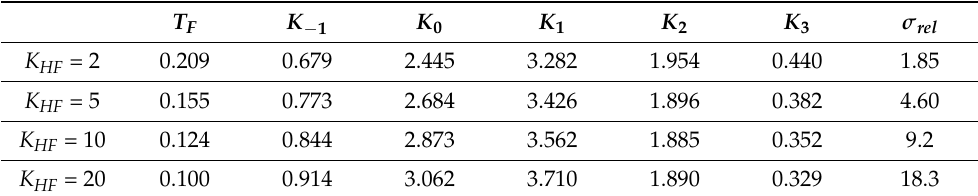
Table 3. The calculated filter time constants T F and controller parameters at different noise gains K HF .